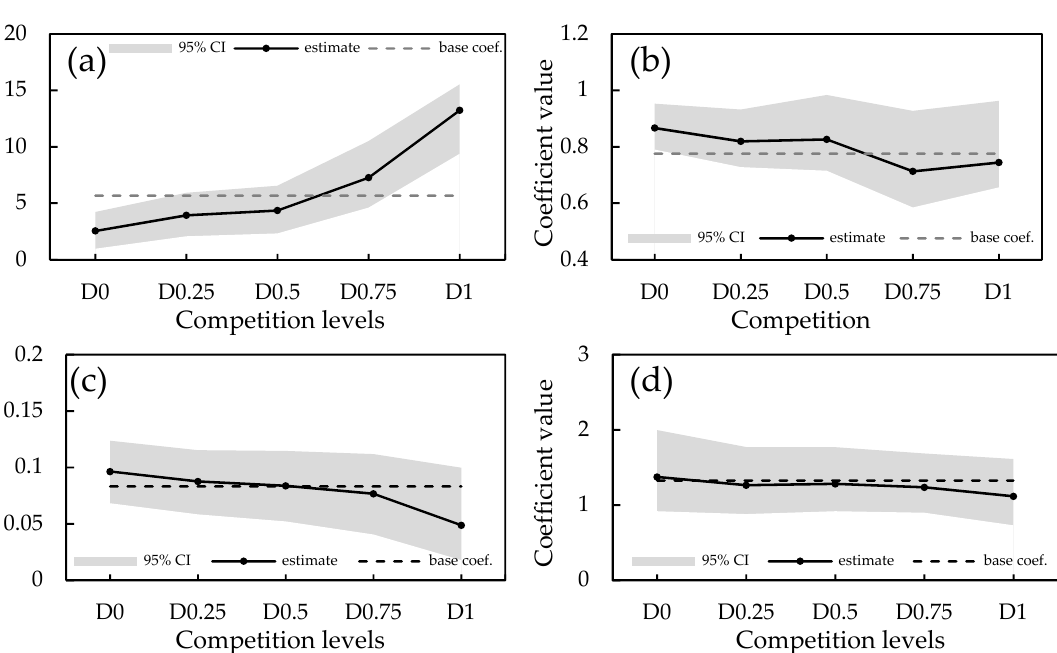
Table 4. The summary statistics of optimal H ‒ D models for five competition levels from 10-fold cross- validation.